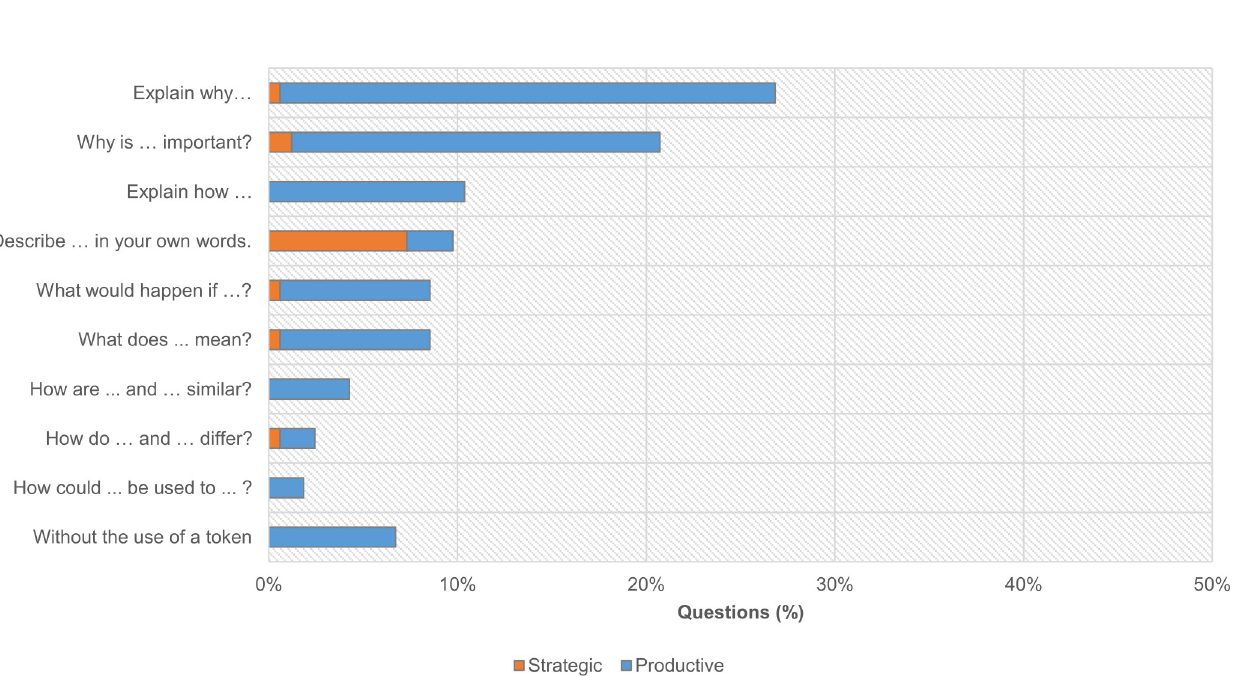
Fig 10. Distribution of ‘productive’ and ‘strategic’ questions (n = 164) according to the question tokens used in their production.